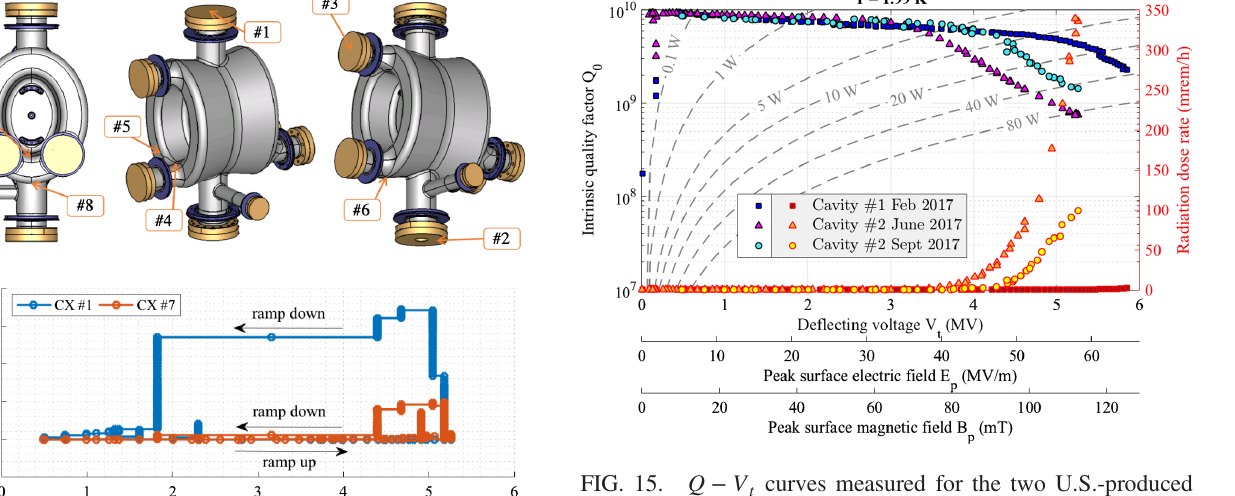
FIG. 15. Q − V t curves measured for the two U.S.-produced SPS-series DQW